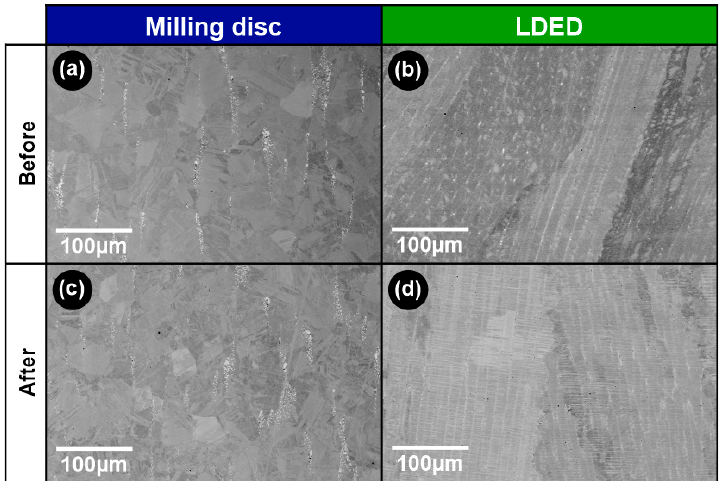
Figure 6. SEM micrographs showing a longitudinal section of samples generated by each technique: disc milling ( a , c ) and LDED ( b , d ) before ( a , b ) and after ( c , d ) veneering furnace cycles.